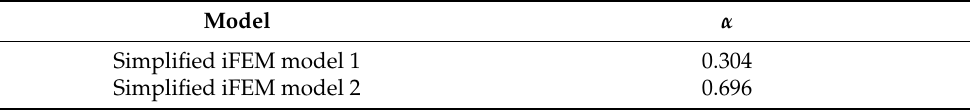
Table 3. Combined model’s weighting coefficients.